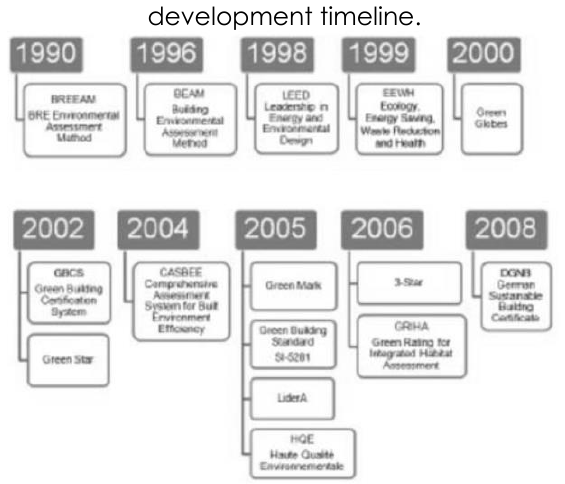
Figure 3. Rating system based on their development